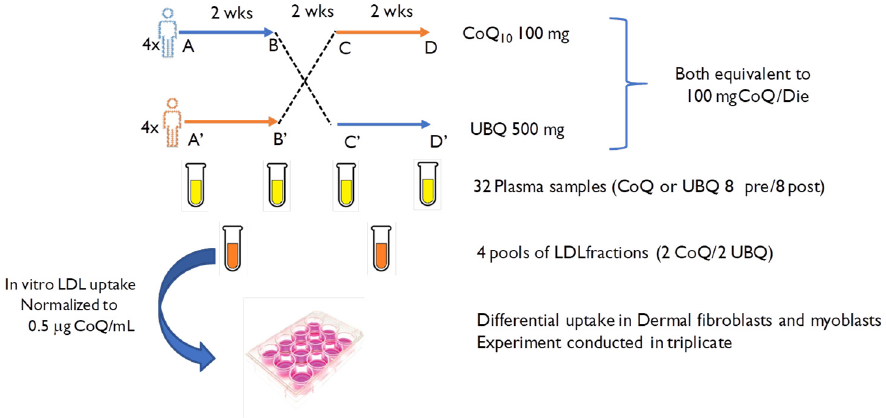
Figure 2. Layout of the study design. A and A’: pre-supplementation; B and B’: post-supplementation; C and C’: pre-supplementation after wash-out; D and D’: post-supplementation post wash-out. After collecting the blood samples, a total of 32 plasma samples were obtained and divided into 16 plasma samples (pre- and post-supplementation) each for crystalline CoQ 10 (CoQ) and Ubiqsome (UBQ). From these plasma samples, 4 pools of enriched LDLs were extracted and divided into 2 each for CoQ and